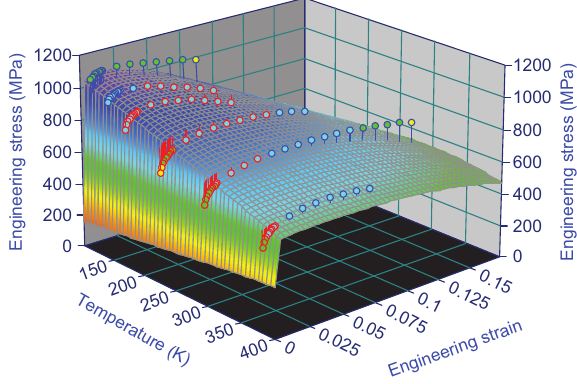
Figure 8 Stress-strain diagram for a wide range of temperatures at a shear strain rate of 5 × 10 2 /s.